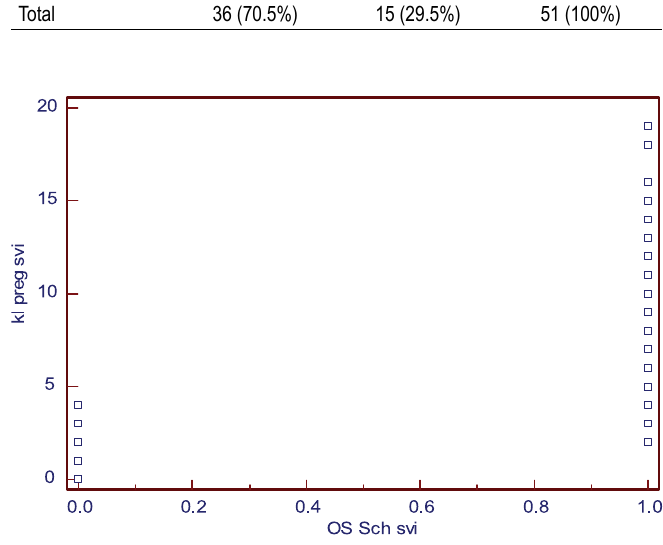
FIGURe 1. Correlations between the positive findings of clinical examination of examinees and oSd